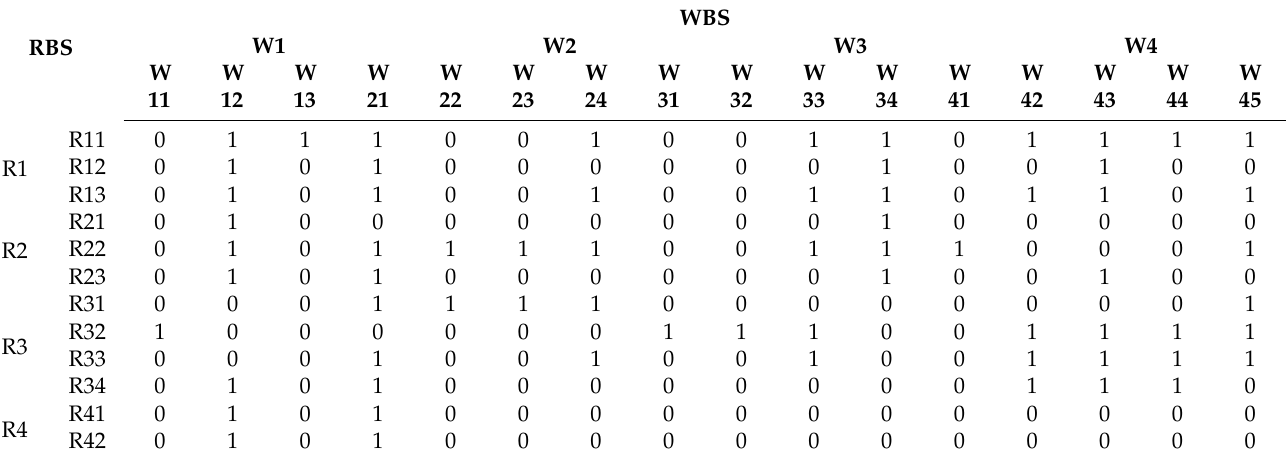
Table 4. WBS-RBS coupling matrix of the electric vehicle